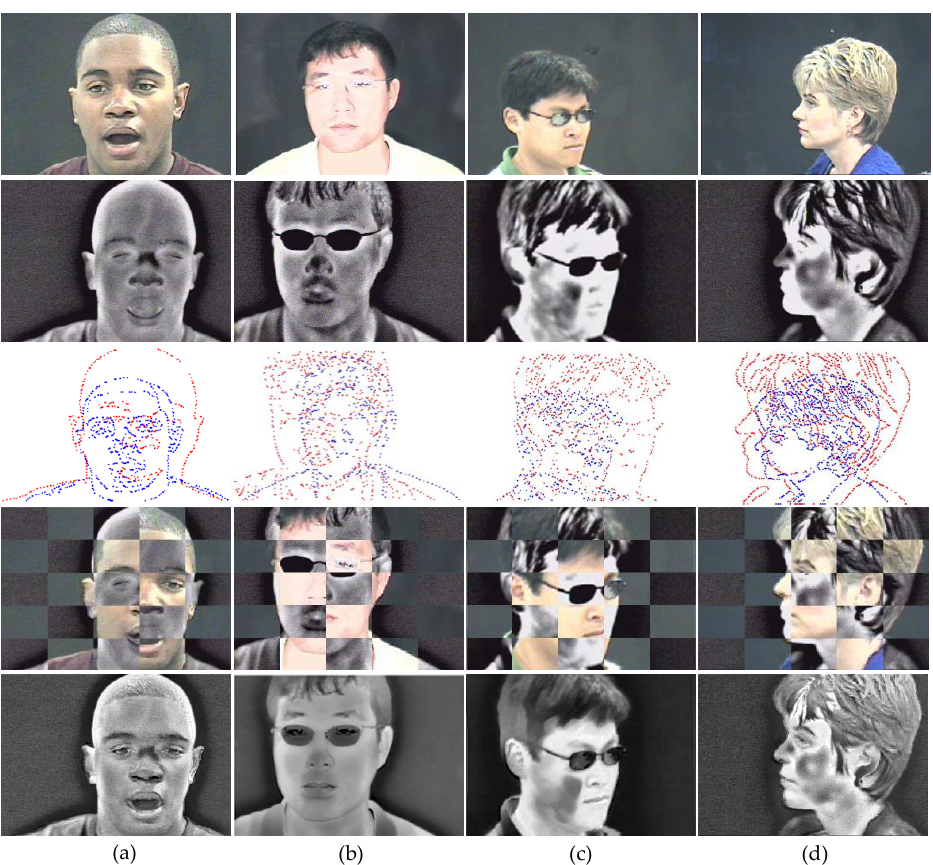
Figure 4. Registration and fusion results of our method on four typical unregistered visible/infrared image pairs in the database of UTK-IRIS. ( a ) Charles; ( b ) Heo; ( c ) Meng; ( d ) Sharon. Appl. Sci. 2019 , 9 , x FOR PEER REVIEW